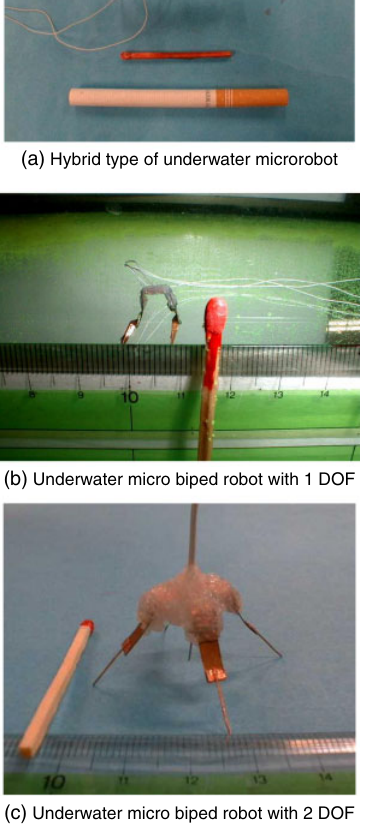
Figure 3 View of the developed micro-robot. (a) Hybrid underwater micro-robot, (b) underwater micro biped robot with one degree of freedom, (c) underwater micro biped robot with two degrees of